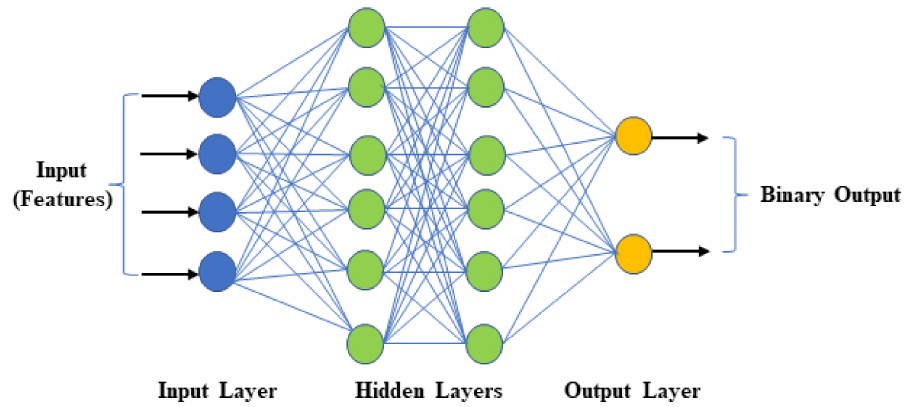
Figure 5. Structure of DNN binary